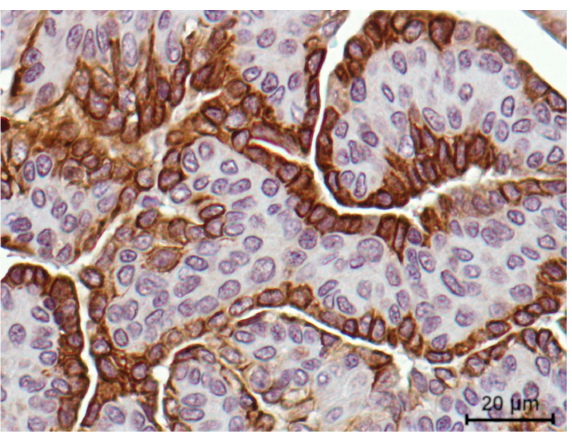
Figure 5. VISTA immunostaining intensity was revealed to be stronger in the epithelial luminal zones of the tumor (3+ score) when compared to the mesenchymal cells, reported in an aggressive feline mammary carcinoma (400× magnification).